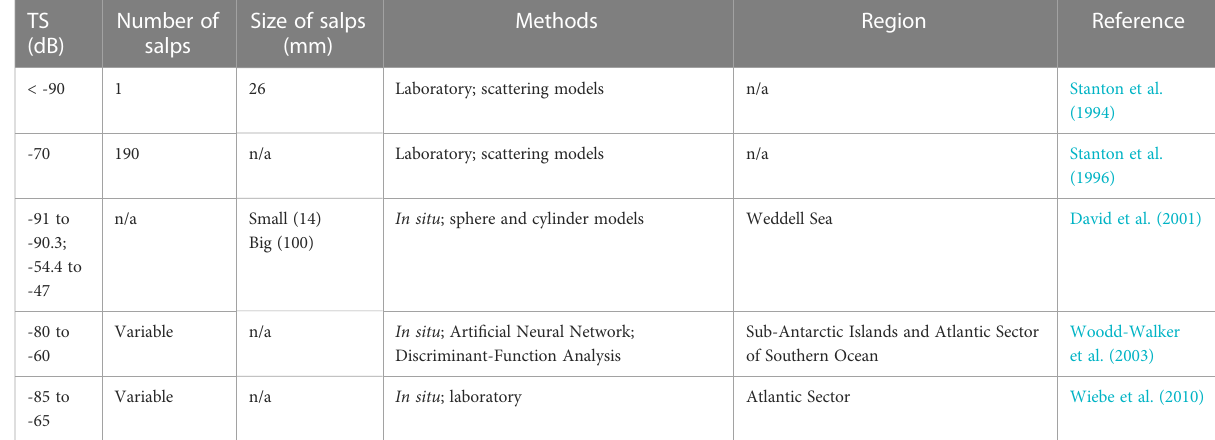
TABLE 1 Target strengths (TS; dB), details on number of salps, size of salps (mm where numbers are given), study methods, and study regions of referenced past work that acoustically analyzed salps in the Southern